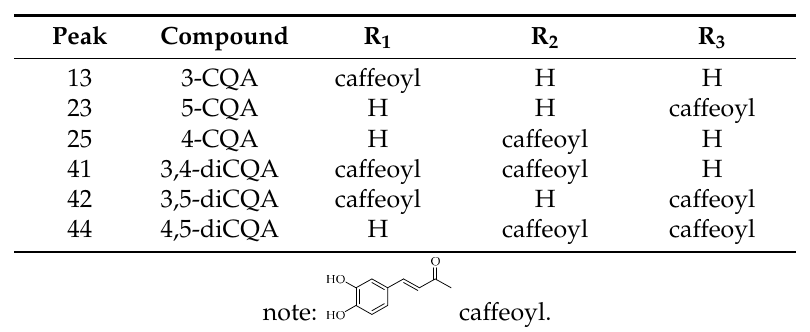
Figure 4. Structures of 6 CGA reference standards identified from Kuding tea.